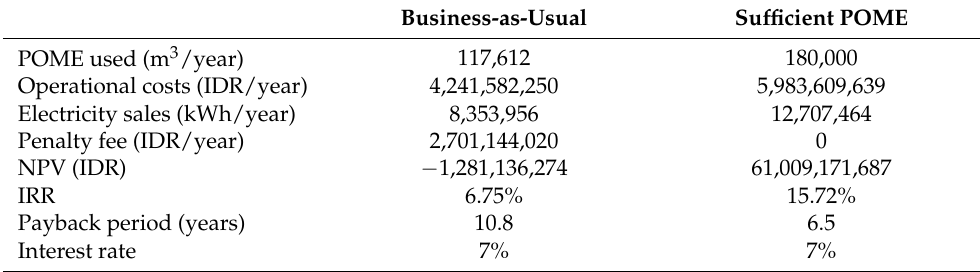
Table 8. Profitability comparison of the two